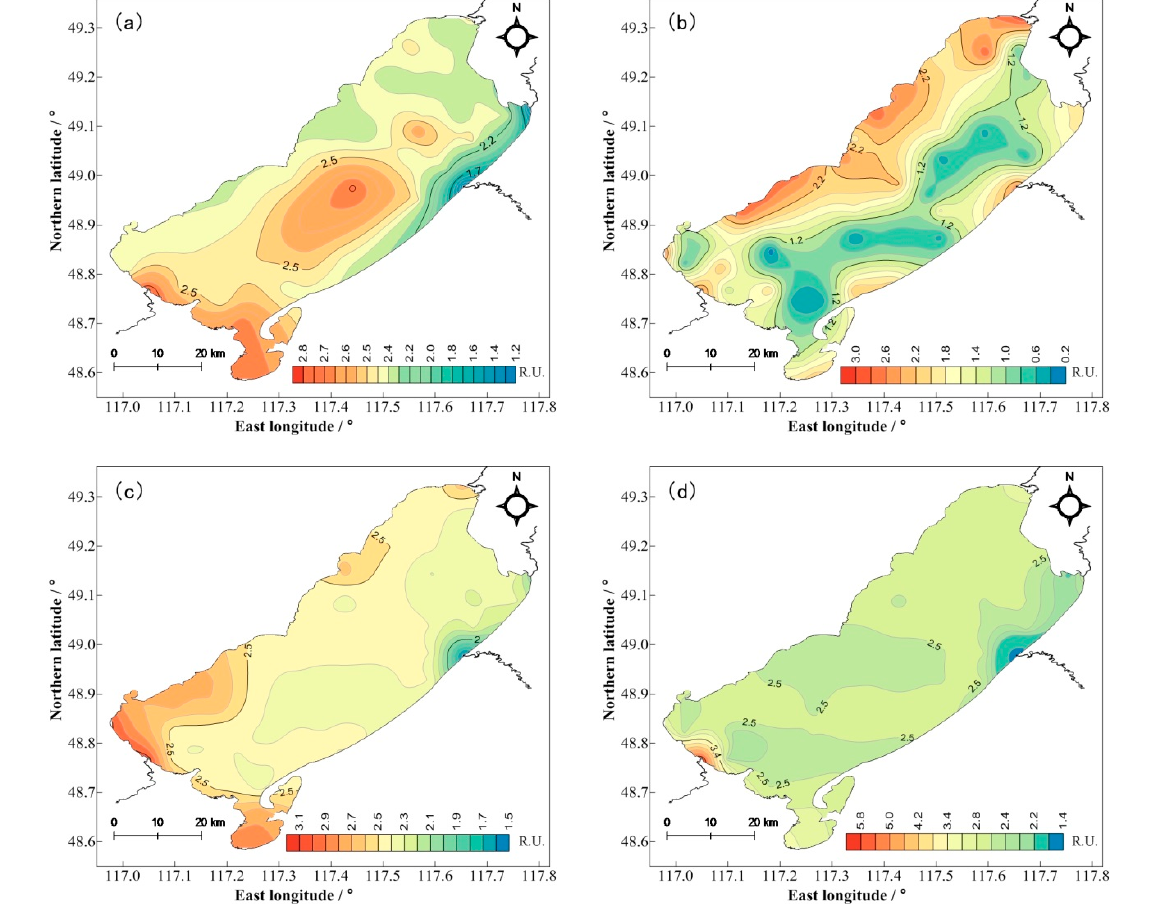
Figure 5. Spatial distributions of the total fluorescence intensities of FDOM in ( a ) autumn: October 2018, ( b ) winter: March 2019, ( c ) spring: May 2019, and ( d ) summer: July 2019.